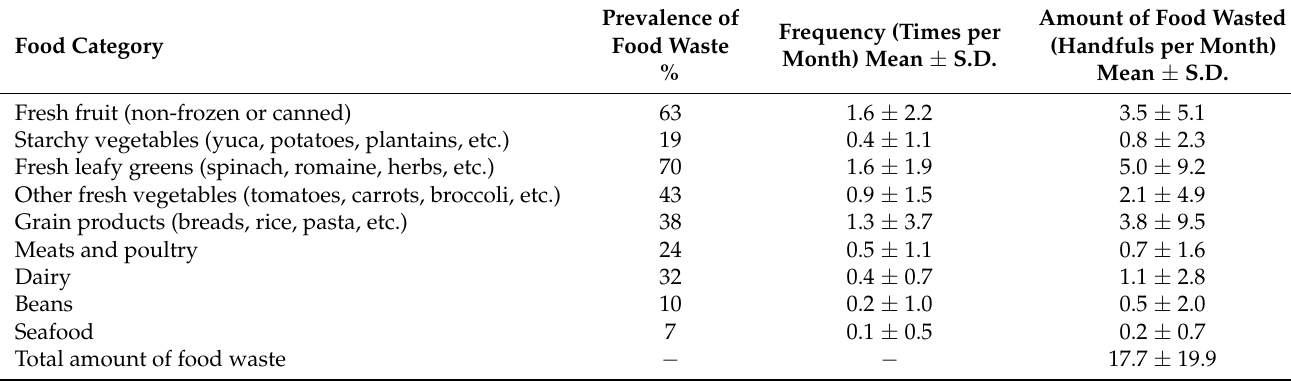
Table 2. Prevalence of food wasted and mean frequency and amount of food wasted per month by food category ( n = 109 *).